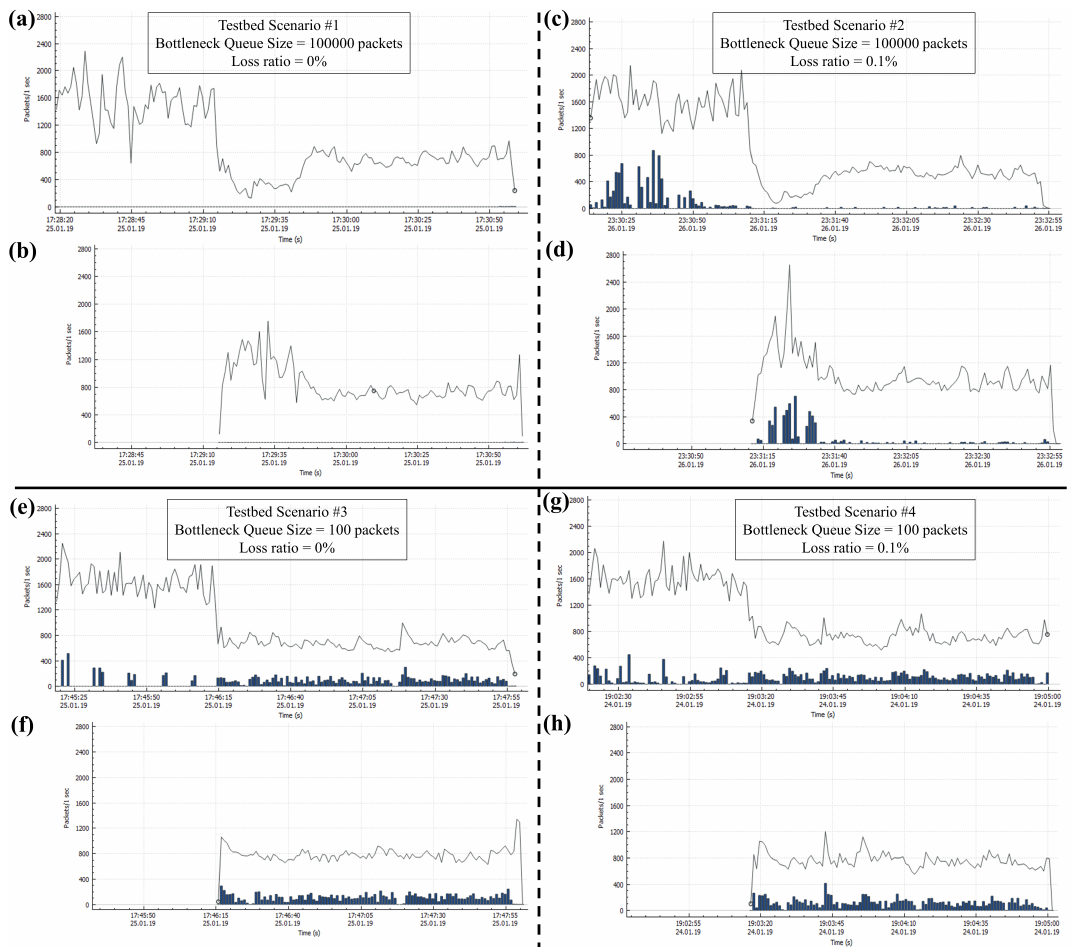
Figure 9. Comparison of input/output packets per second per sender of BBR-ACD for different testbed scenarios — ( a , b ) for Testbed Scenario #1, ( c , d ) for Testbed Scenario #2, ( e , f ) for Testbed Scenario #3, and ( g , h ) for Testbed Scenario #4. The bars indicate the lost number of